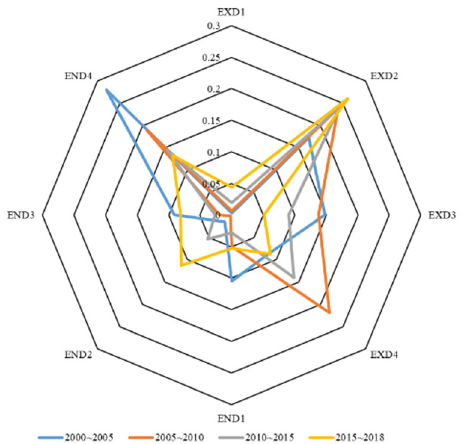
Figure 4. The mean annual variation in the driving forces influencing intensity.